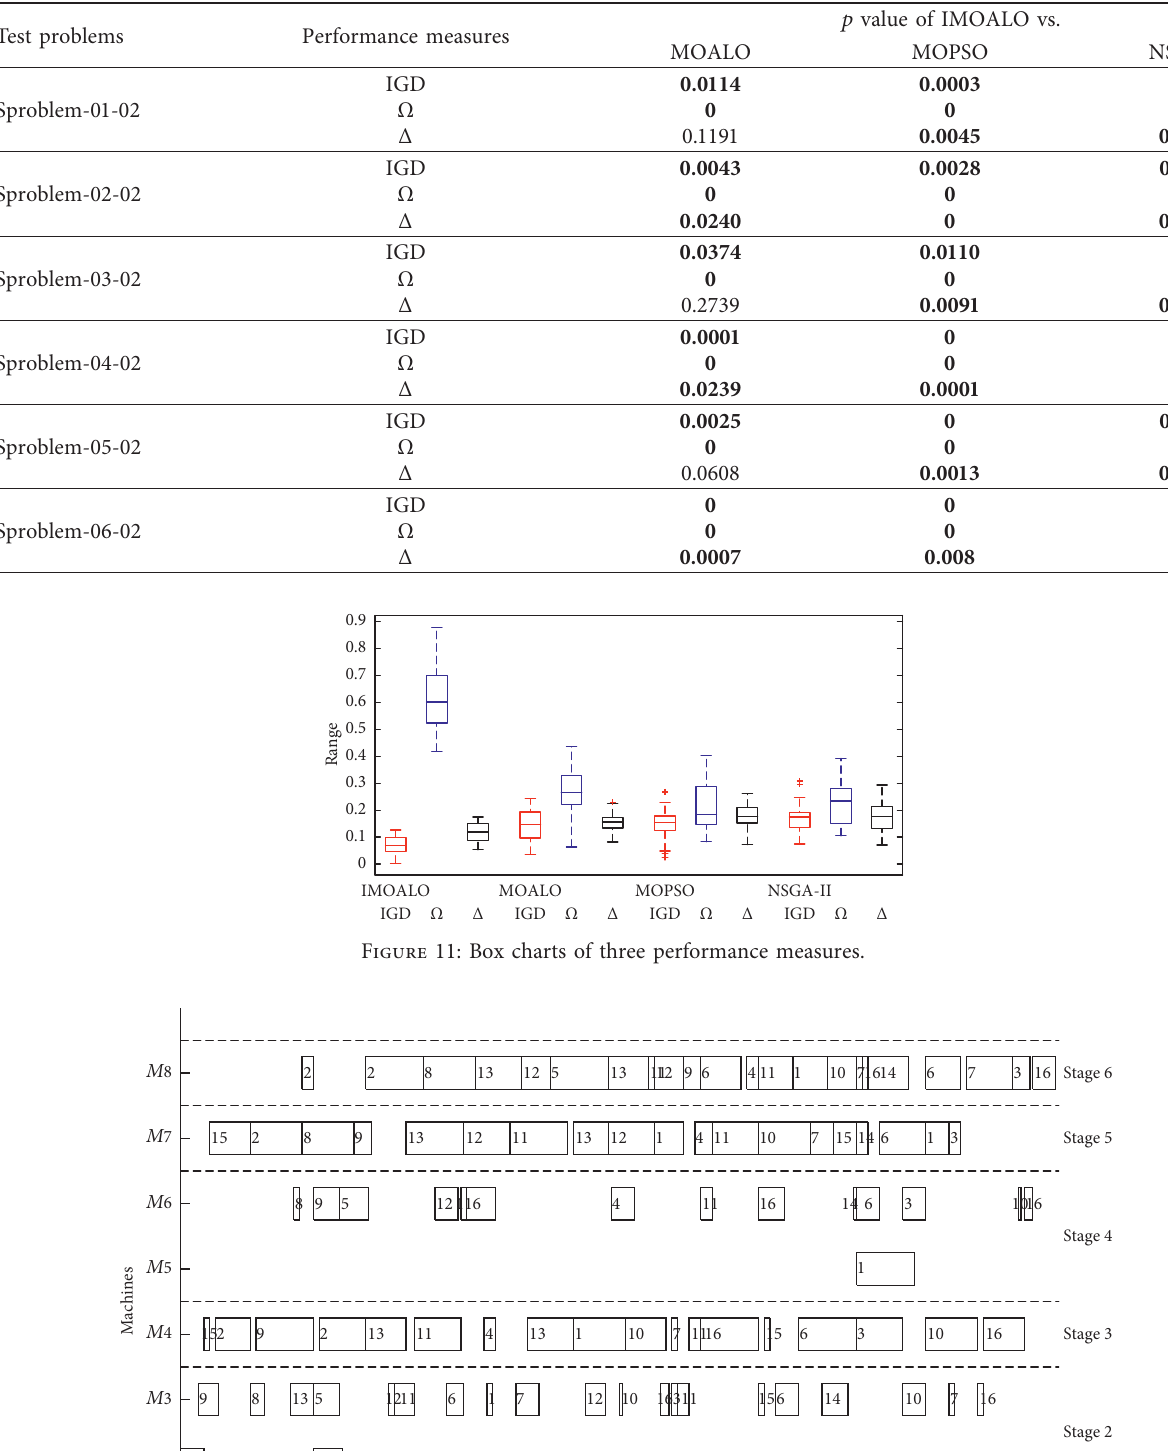
Table 5: T -test of IMOALO vs. MOALO, MOPSO, and NSGA-II.